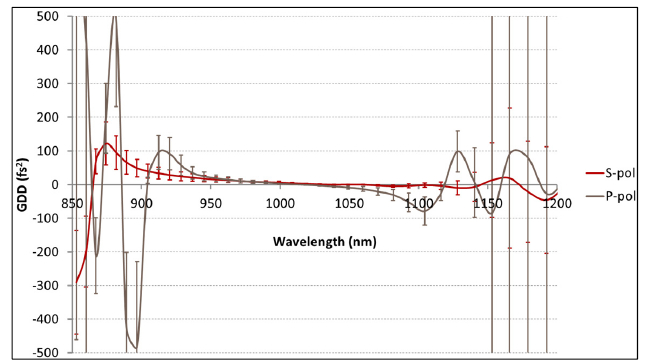
Figure 10. Measured Transmission spectra at 45° AOI for Ppol and Spol for the initial BBHR test coating.